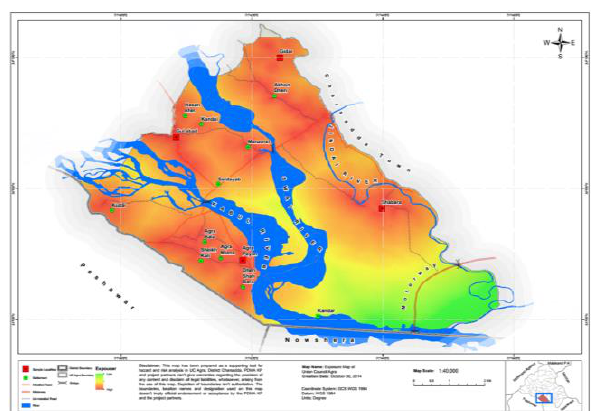
Figure 5. UC Agra-Exposure/ Vulnerability map